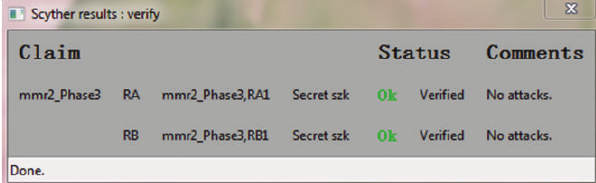
Figure 7: Verification result for Protocol 2-Phase 3, distributed